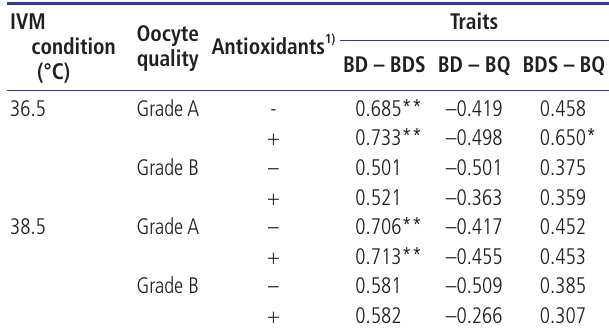
IVM, in vitro maturation. 1) Results are cumulative data from 7 replicates.